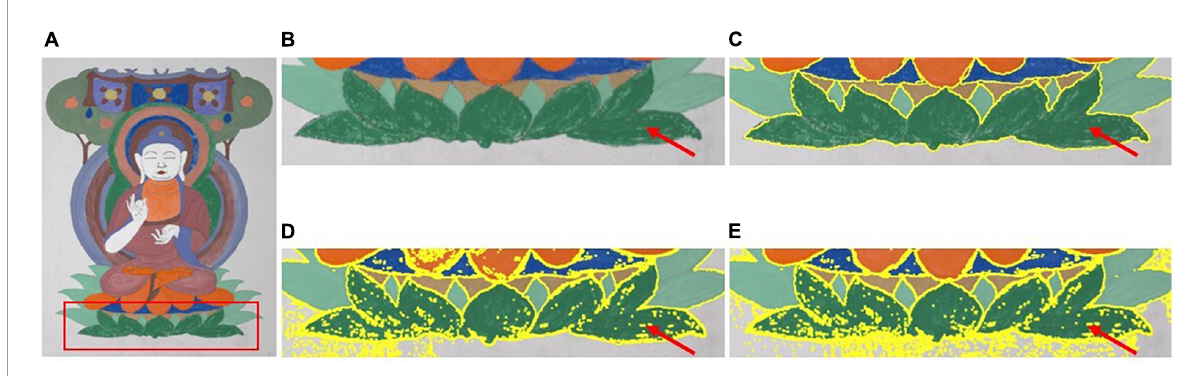
FIGURE6 Comparison of the segmenting results between the proposed method and the methods proposed by Dasgupta (2008) and Yan et al. (2012). (A) Test image. (B) ROI of test image. (C) Proposed. (D) Dasgupta. (E) Yan.